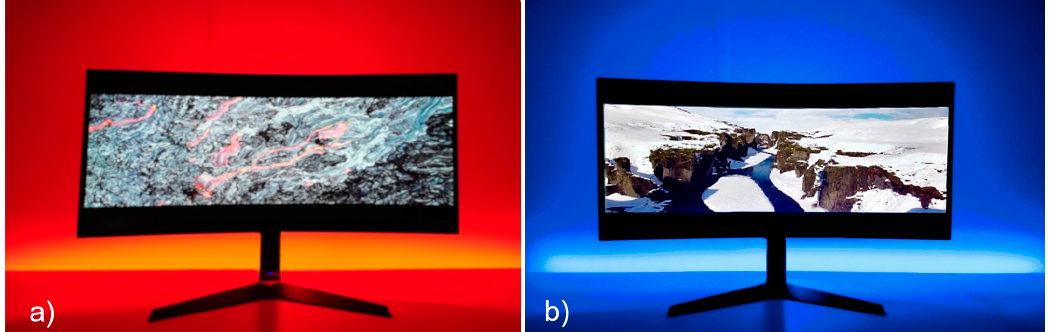
Figure 5. Real scenario: ( a ) red setting; ( b ) blue setting.